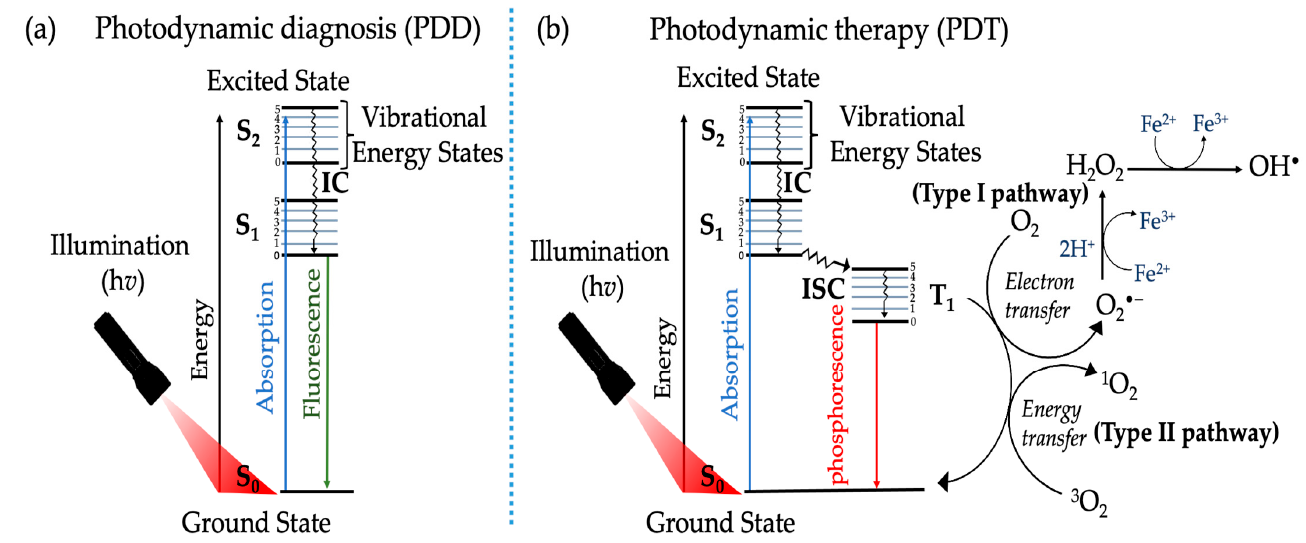
Figure 1. Modified Jablonski energy diagram depicting the underlying photophysical and photochemical reactions of PSs in photodynamic diagnosis (PDD) ( a ) and photodynamic therapy (PDT) ( b ).